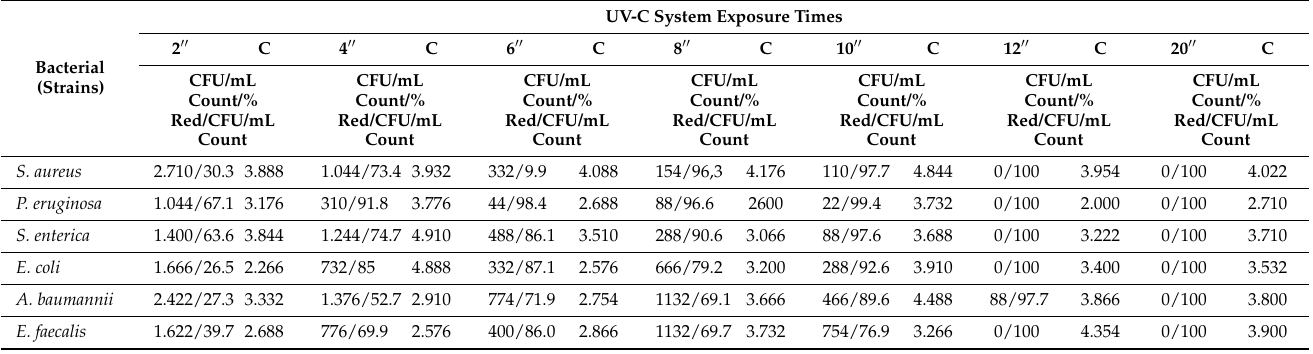
CFU count: colony forming units count; red: Reduction; C: